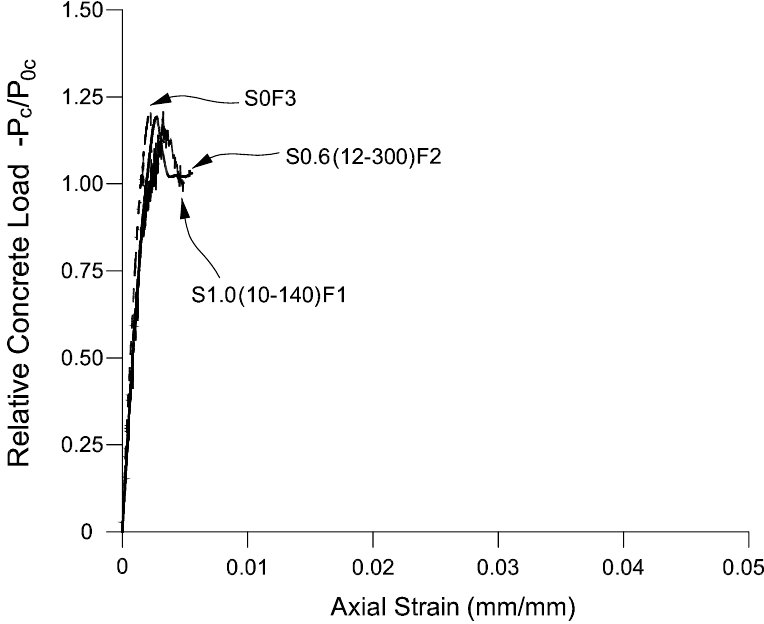
Figure 8. Normalized stress–strain curves of FRP-TSR confined